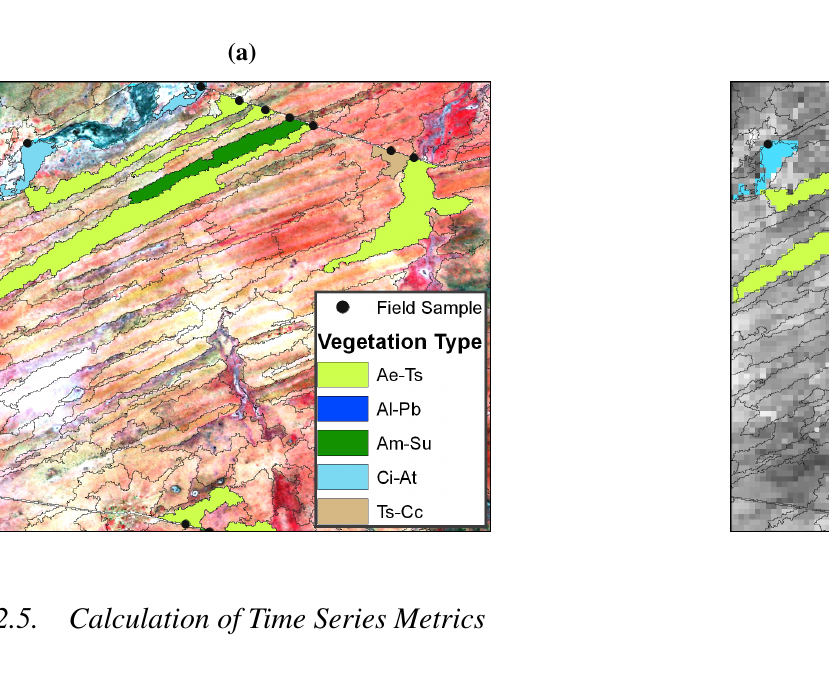
Figure 2. Examples for the generation of training data from in-situ to MODIS 232 m pixel size. Botanical field plots were intersected with homogeneous segments retrieved from Landsat imagery [2a]. The training data on the 232 m MODIS pixel is visualized in [2b], displayed on the MODIS image of the 81th day of the year (DOY) 2004. Note the detailed description of the vegetation type legend in Table